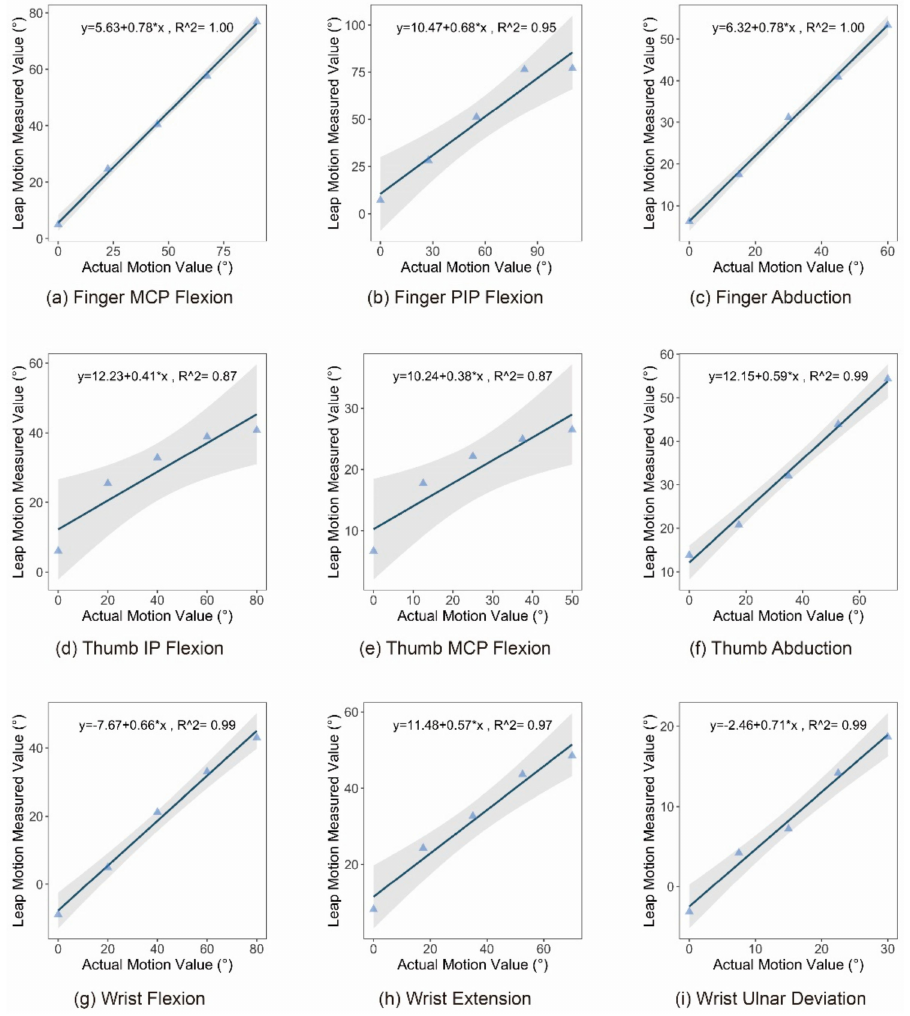
Figure 17. The linear fit graph between Leap Motion measured value and actual value for each hand motion primitive